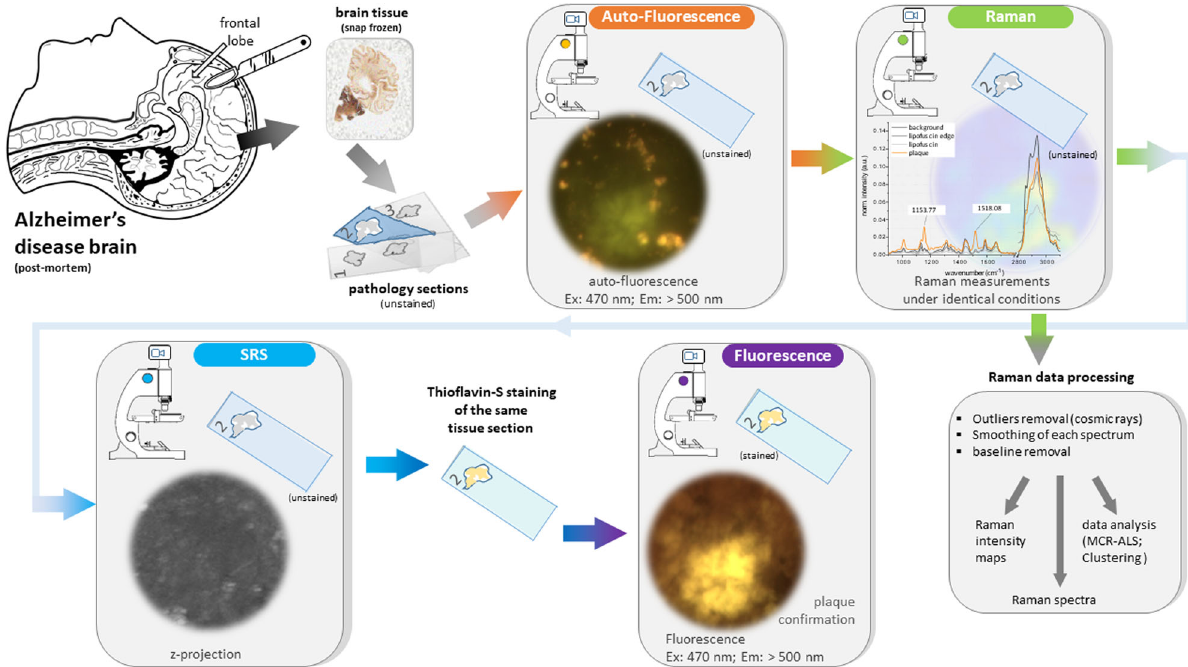
Fig. 1 Experimental work fl ow. Brain autopsy is performed within 9 h post-mortem and the tissue is immediately snap-frozen to − 80 °C. Next, the tissue is cut at 20 µ m and mounted on a CaF 2 microscope slides. Afterwards, the section is imaged under the fl uorescence microscope. Subsequently, Raman maps are recorded. Hereafter, the tissue is measured across the amide-I protein peak using the SRS microscope. Following SRS, the tissue section is stained with thio fl avin-S and imaged under the fl uorescence microscope for plaque con fi rmation. Finally, the data are processed and